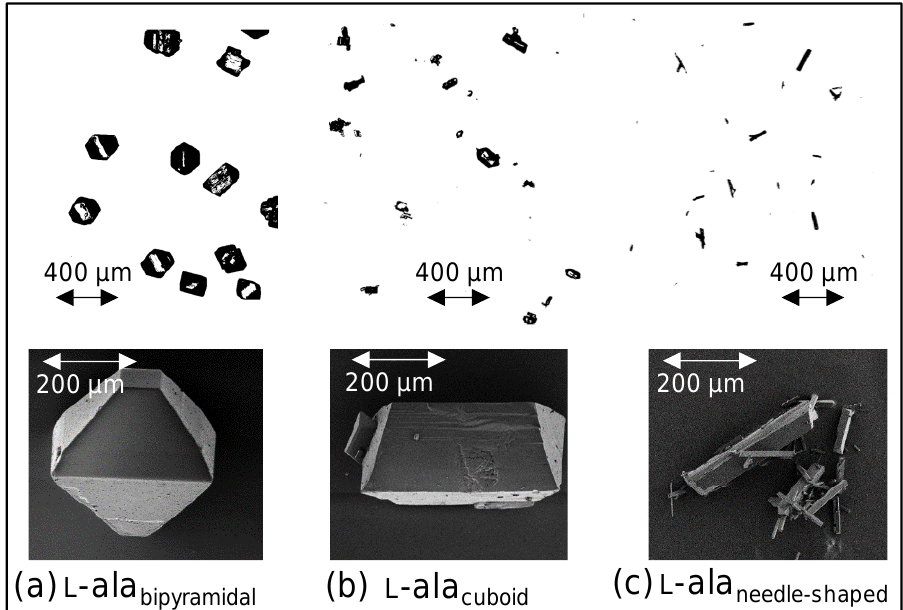
Figure 2. Upper half: exemplary QICPIC binary images of ( a ) bipyramidal—no L-GA impurity, ( b ) cuboid — 2.9 g L-GA kg − 1 water , and ( c ) needle-shaped 5.8 g L-GA kg − 1 water. Lower half: corresponding scanning electron microscope images.